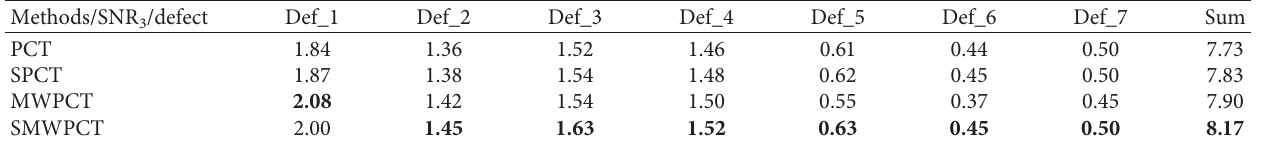
Table 3: SNR 3 of different